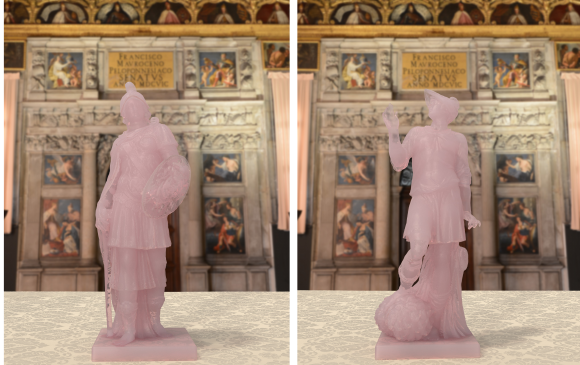
Figure 22. 3D visualization of the sugar sculptures of Pallas and